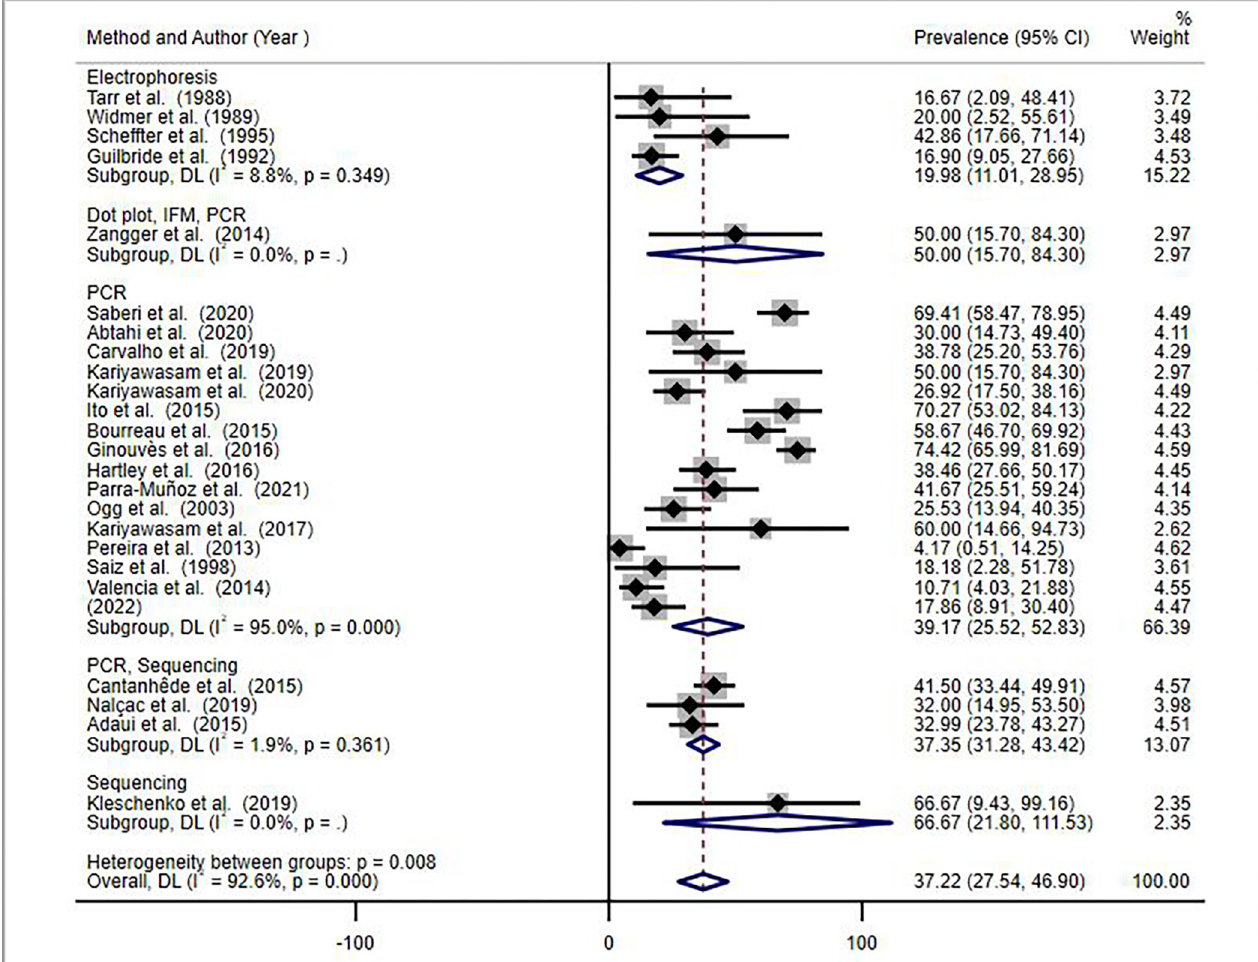
Fig 4. Forest plot showing the pooled LRV prevalence estimate by detection method in Leishmania parasites and/or lesions of patients with CL, 2021.